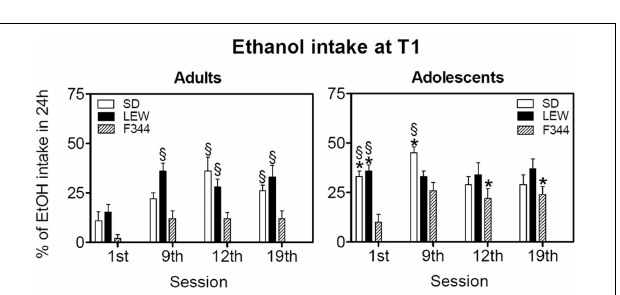
FIGURE 5 | Ethanol intake during the first hour of the drinking session (T1). Data are expressed as means ± SEM. * p < 0.05 vs. the corresponding value in adult rats, § p < 0.05 vs. corresponding value of Fischer 344 (F344) rats by three-way ANOVA for repeated measures followed by Tukey’s post hoc test.